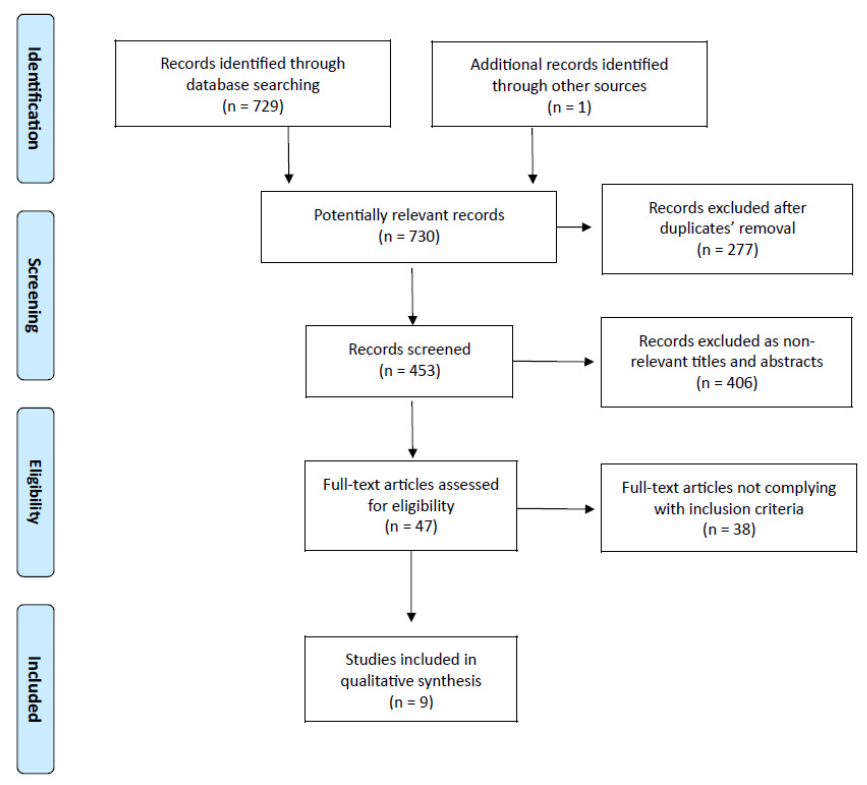
Figure 1. PRISMA flow chart of literature search.